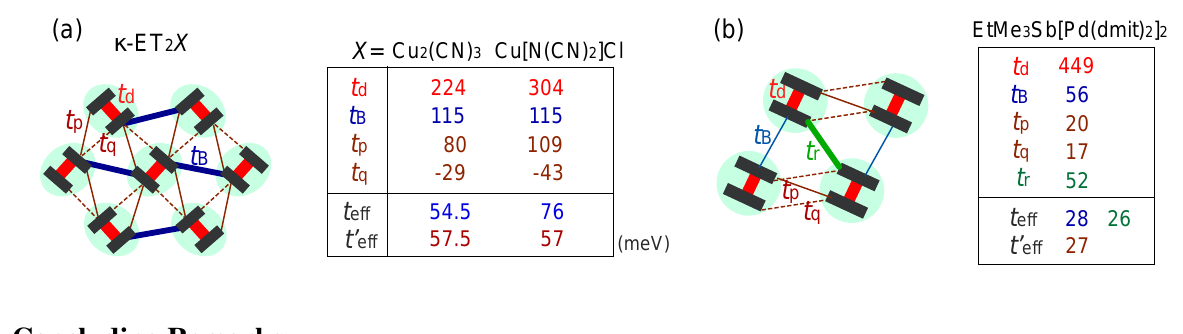
Figure 23. Transfer integrals of ( a ) κ -ET ( b ) EtMe transfer integrals, t dimer approximation (Section